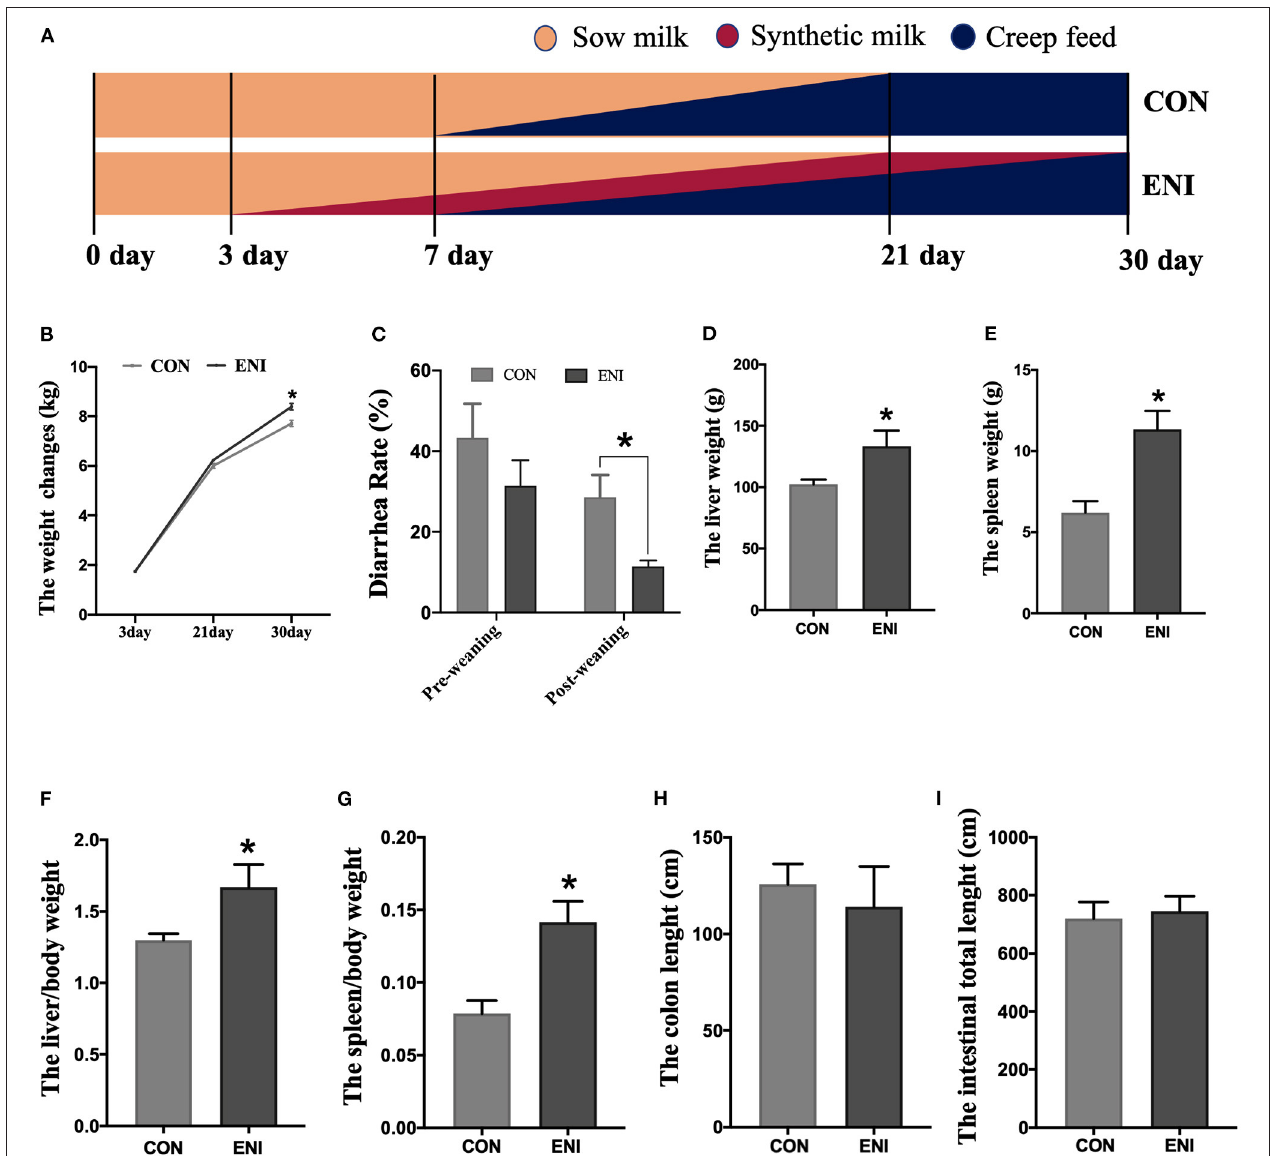
FIGURE 1 | Effects of early-life nutrition interventions on growth performance and visceral organs in piglets. CON, control group, ENI, early-life nutrition interventions group. (A) The feeding mode diagram. (B) The weight changes of piglets at 3, 21, and 30 days of age in each group. (C) The diarrhea rate of pre-weaning and post-weaning of piglets. (D) The liver weight of piglets in each group. (E) The spleen weight of piglets in each group. (F) The relative weights of liver to living body weight. (G) The relative weights of spleen to living body weight. (H) The length of colon in each group. (I) The length of whole intestine. Data are expressed as mean ± SEM ( n = 4). The independent-samples t -test was used to compare data between two groups. * P <